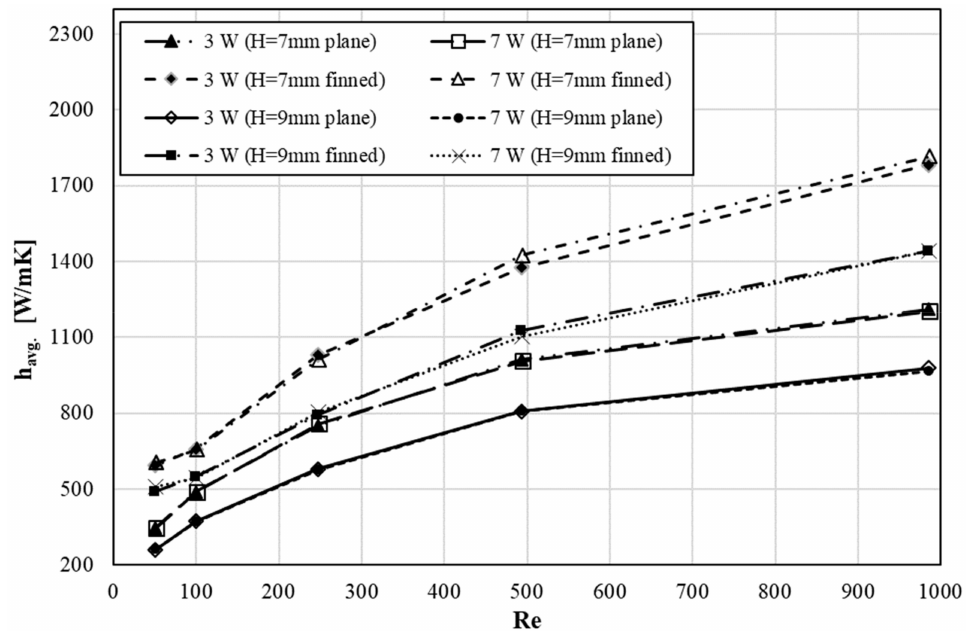
Figure 12. Comparison of the average heat transfer coe ffi cients versus Reynolds